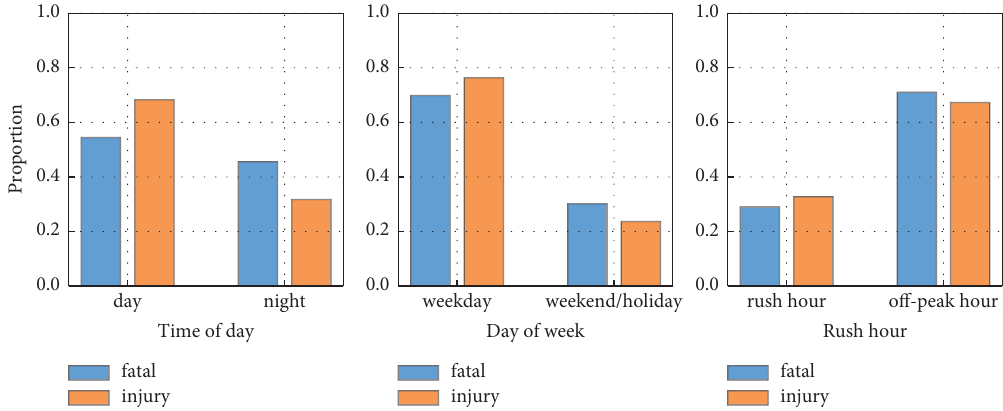
Figure 2: The proportion of different accident types under time-related